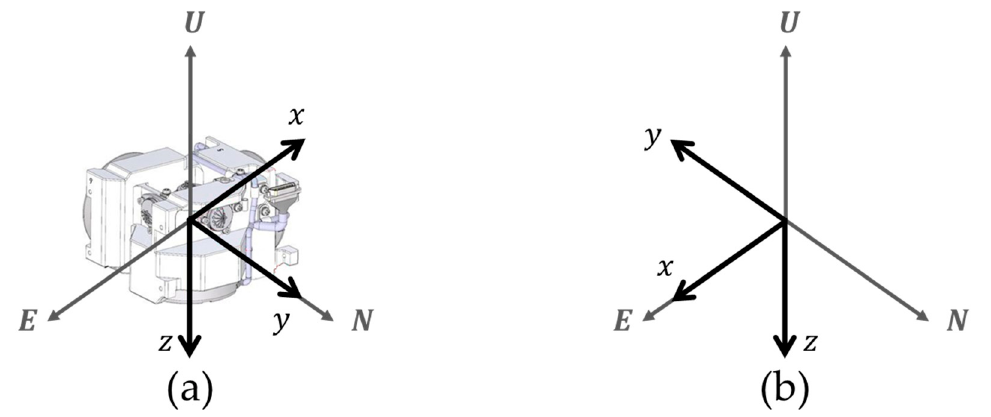
Figure 5. Rotation sequence in the Z − axis down position: ( a ) initial position; ( b ) position after rota- tion.